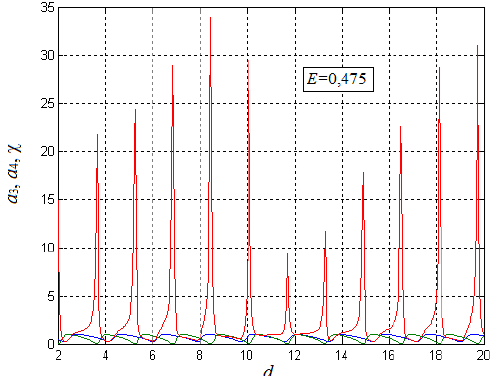
Figure 9: Selectivity at particle energy E =